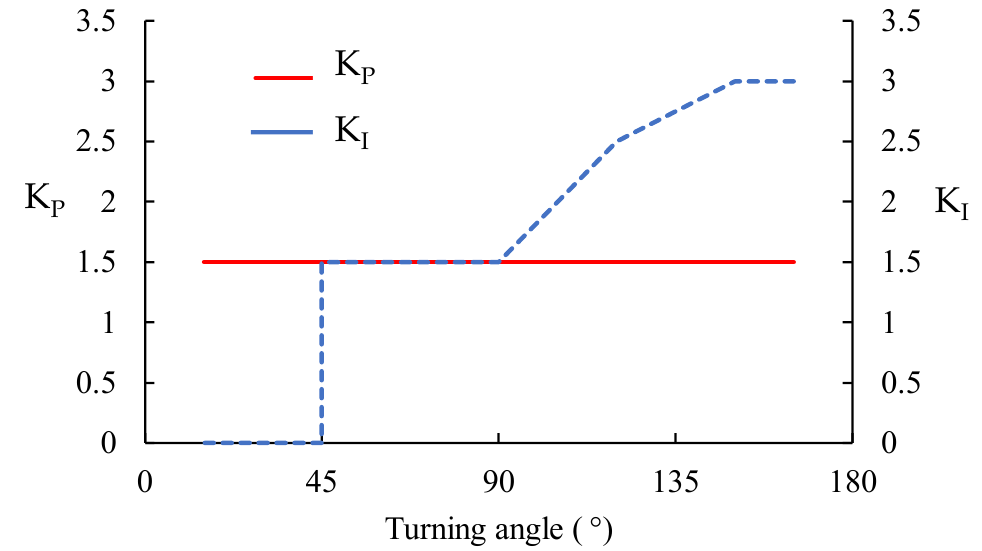
Figure 11. Controller gains, K P and K I , that are suitable for specific turning angles according to the experimental